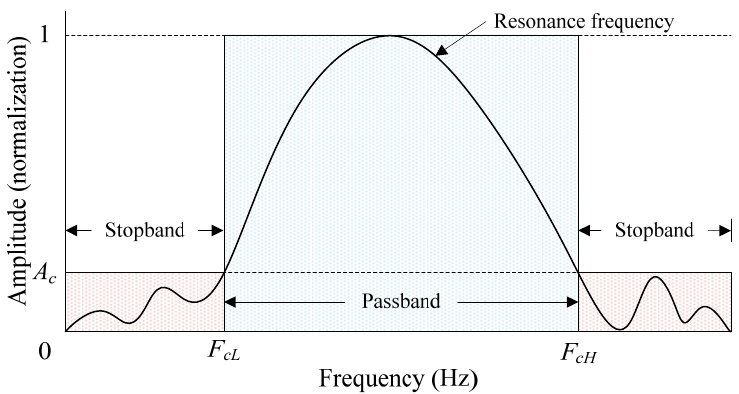
Figure 3. Illustration of the design map of a bandpass ( A c = 0.1) filter for radar surface velocimetry.